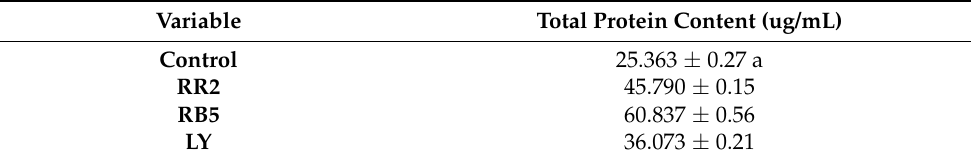
Table 2. Effect of different azo dyes on the total protein content of P. caudatum (UR03).